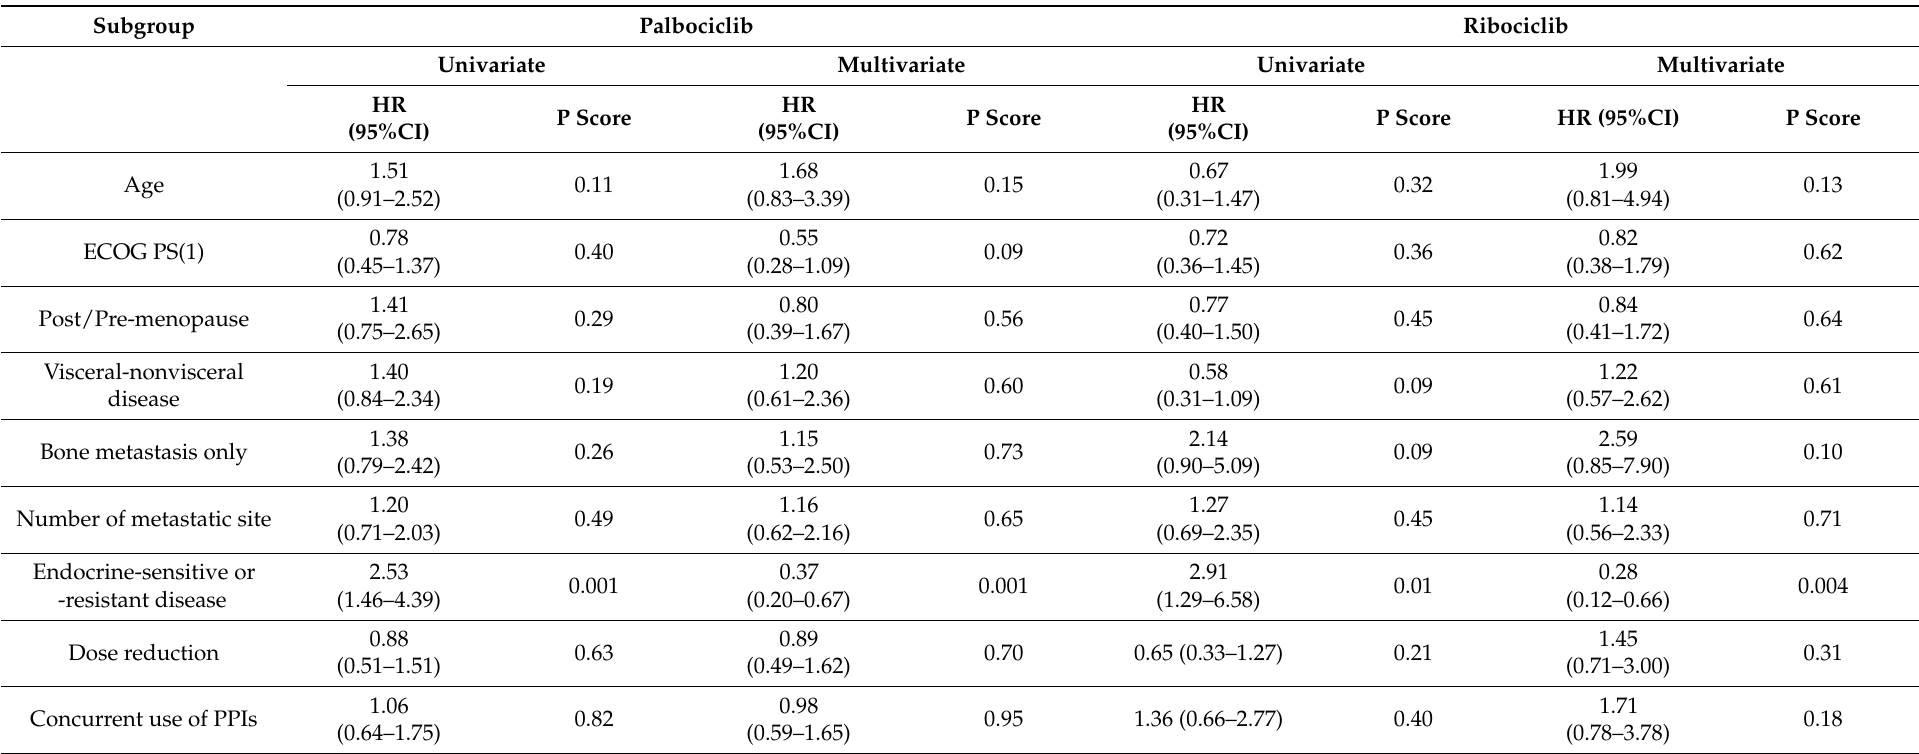
Table 5. Univariate and multivariate analysis for progression-free